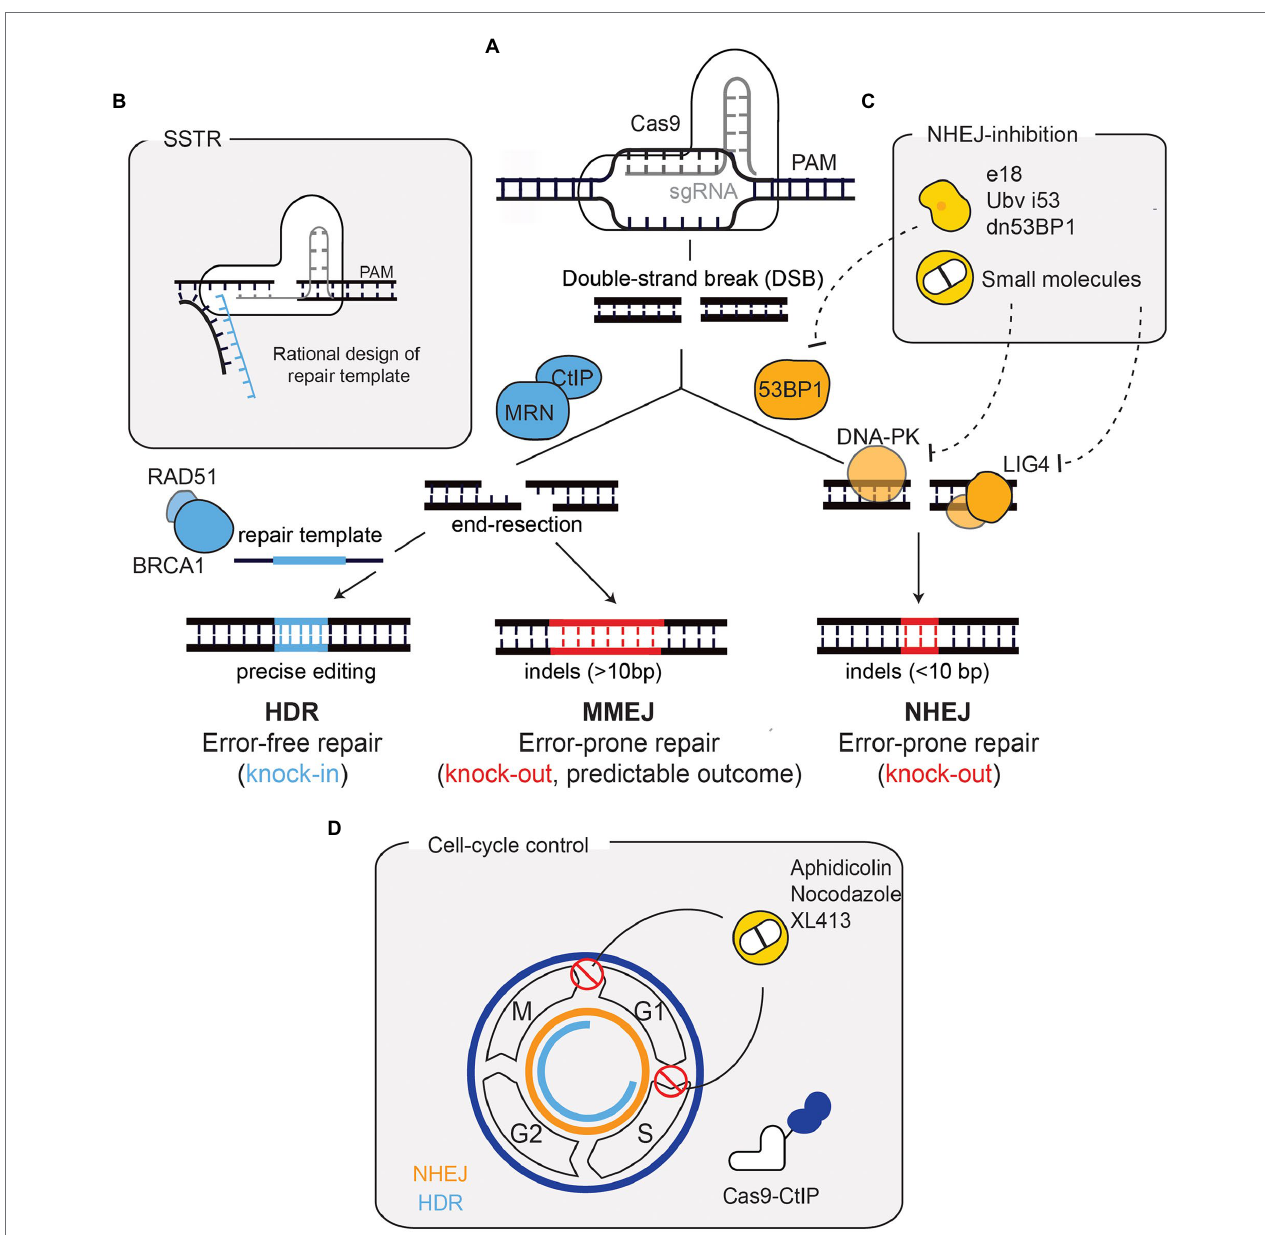
FIGURE 1 | Repair outcomes after a Cas9-induced DNA double-strand break (DSB) and strategies for enhancing precise repair. (A) Cas9, targeted by a sgRNA, induces a DSB in a precise region of the genome. Non-homologous end-joining (NHEJ), promoted by 53BP1, is the default repair pathway. Through the coordinated action of factors such as DNA-PK and LIG4, NHEJ repairs the DSB by re-joining the DNA-ends in an error-prone manner. This results in small insertions and deletions (indels) that can generate a loss-of-function allele if a frameshift is generated. If end-resection occurs [mediated by CtIP and MRE11-Rad50-NBS1 (MRN)], microhomology-mediated end-joining (MMEJ), or homology-directed repair (HDR) function. The repair outcome following MMEJ-mediated repair can vary, although this can be predicted since it depends on regions of microhomology and leads to larger indels. HDR, mediated by factors such as BRCA1 and RAD51, relies on a repair template and hence is error-free, leading to precise genomic alterations. (B) The use of ssDNA oligonucleotides (ssODN) as donor templates has also been developed to harness HDR. This process is called single-stranded templated repair (SSTR). SSTR is generally more efficient due to the asymmetry of the Cas9-DNA complex, which leads to the release of the PAM-distal non-target strand. Therefore, a rational design of the ssODN donor template complementary to the strand that is first released improves precise editing. (C) The inhibition of NHEJ has been used to improve precise repair following Cas9-breaks. 53BP1 inhibition through ubiquitin variants, dominant negative forms, or expression of factors that displace 53BP1, has proven useful. Small molecule inhibitors against DNA-PKcs and LIG4 have also been used. (D) Cell cycle manipulation has also proved useful for enhancing HDR. HDR (depicted in blue) is only active in S/G2/M phases, contrary to NHEJ (depicted in orange), which is active throughout the cell cycle. Strategies to improve HDR have included the use of compounds (such as XL413, aphidicolin, and nocodazole) to block cells in HDR-permissive phases. A Cas9-CtIP fusion allows end-resection (and subsequently HDR) to occur throughout the entire cell- cycle. PAM, protospacer